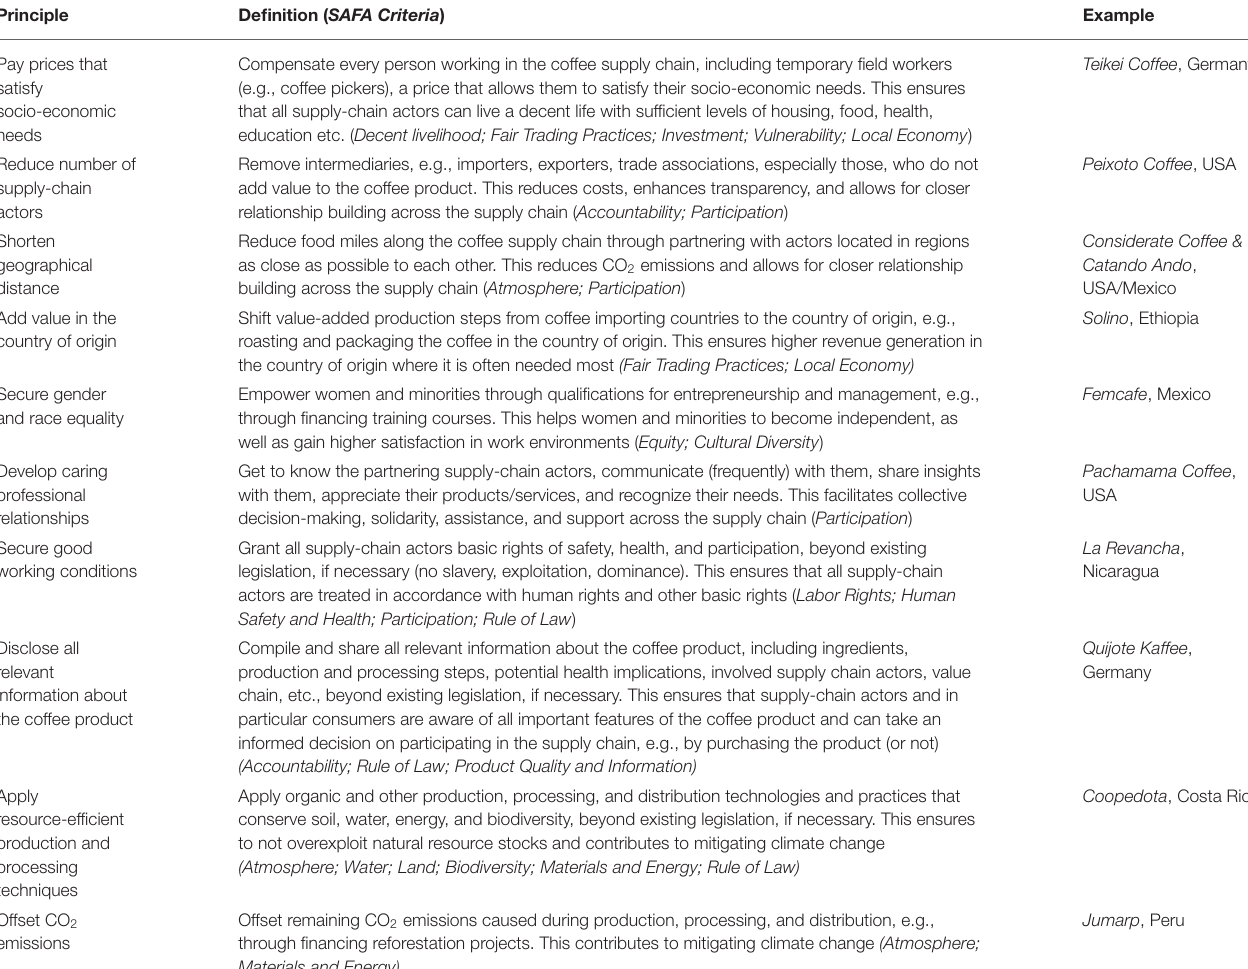
TABLE 2 | Design principles for small intermediary businesses for sustainable international coffee supply, adapted from Weber et al. (2020), with correspondence to SAFA criteria and exemplary coffee businesses that have implemented the respective principle.